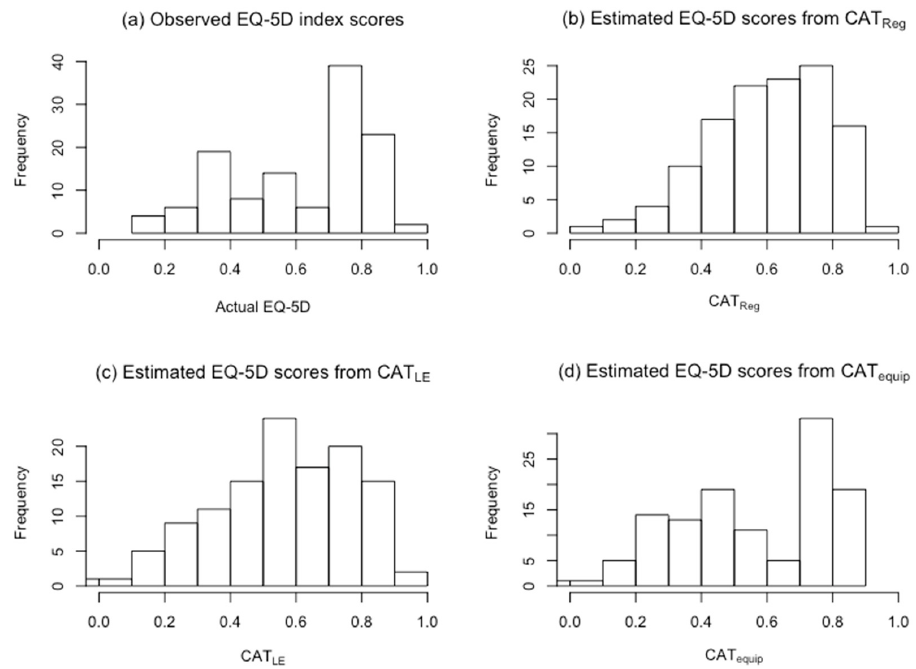
Figure 4. Histograms of observed EQ-5D index scores and estimates from CAT Reg , CAT LE , and CAT equip.